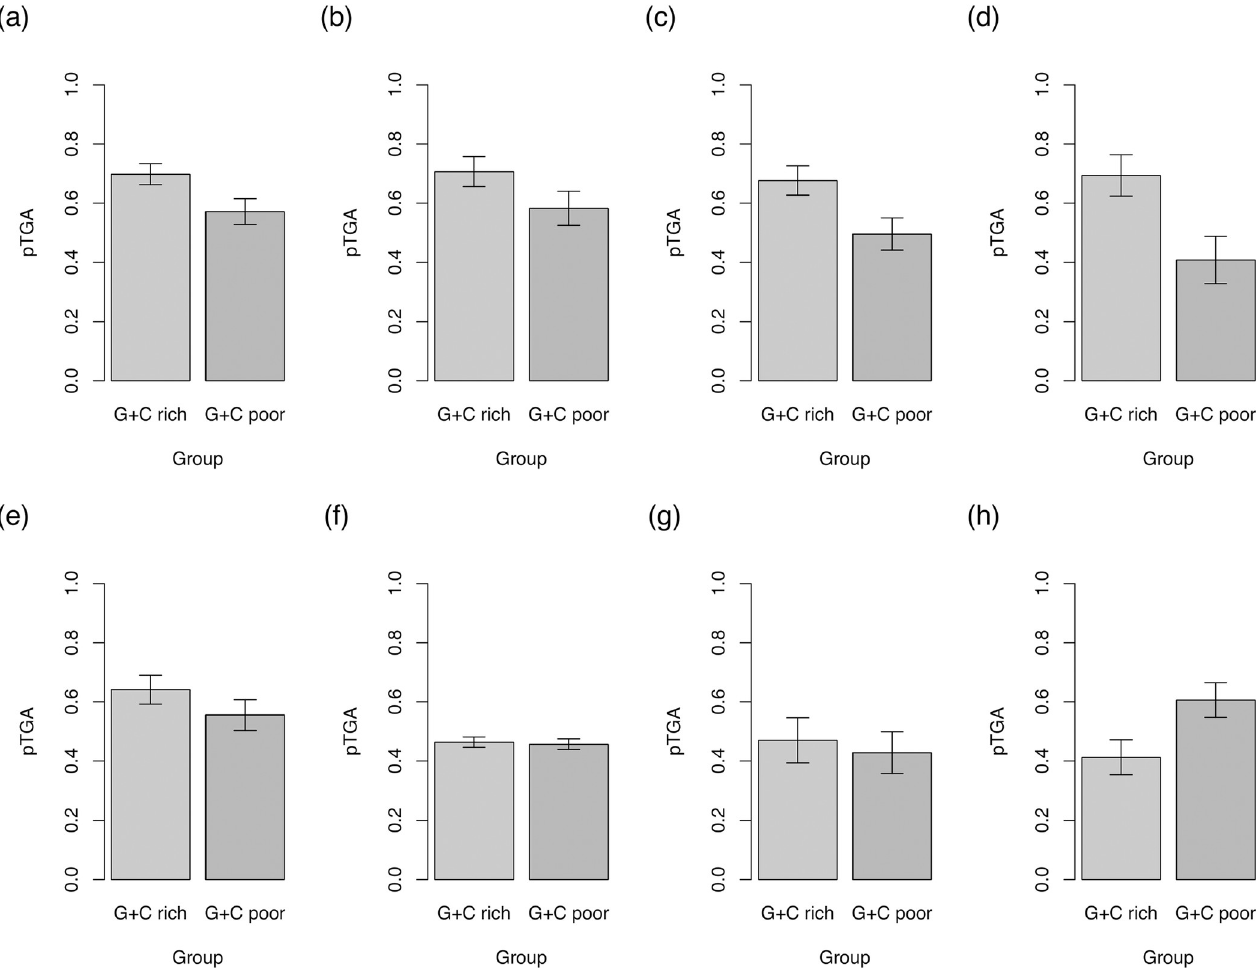
Fig 2. AU : AbbreviationlisthavebeencompiledforthoseusedinFigs 2 to 4 ; 6 to 8 ; S 2 ; S 5 ; andS 6 : Pleaseverifythatallentriesarecorrect : pTGA derived from TAA ! TGA and TGA ! TAA flux for the top 50% of genes by GC content and bottom 50% of genes by GC content in 4 mammalian (a–d) and 4 nonmammalian (e–h) lineages. pTGA is calculated as 1/(1+(TGA ! TAA/TAA ! TGA)) and hence represents the balance between the 2 dominant stop codon flux events. Error bars show standard deviation calculated from 10,000 bootstraps generated by resampling genes in each bin with replacement. Underlying data can be found in S2 Data. Trios analysed are primates (a), dogs (b), cows (c), mice (d), birds (e), nematodes (f), fruit flies (g), and plants (h). Species lists are available at https://github.com/ath32/gBGC.